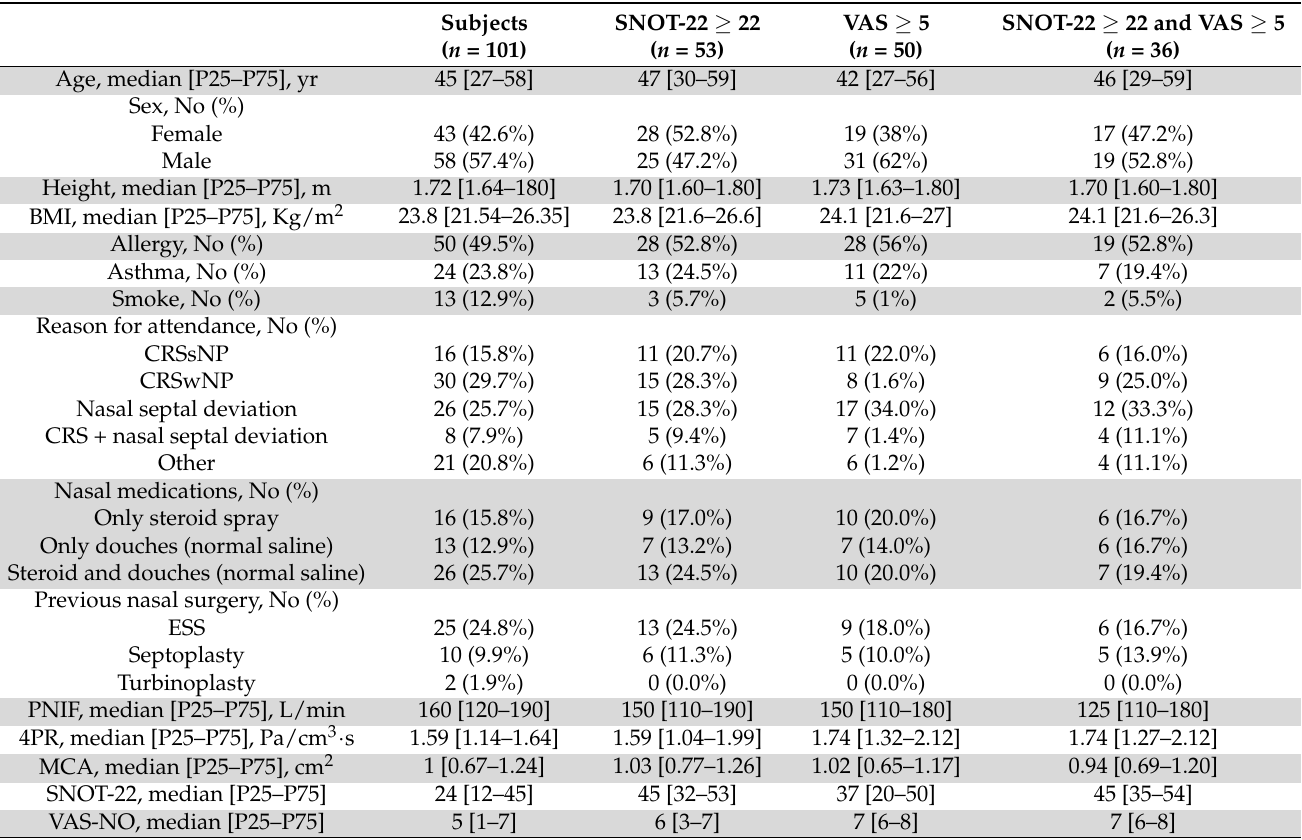
Table 1. Patients’ main clinical characteristics and values of the objective measurements of the nasal function and evaluation of